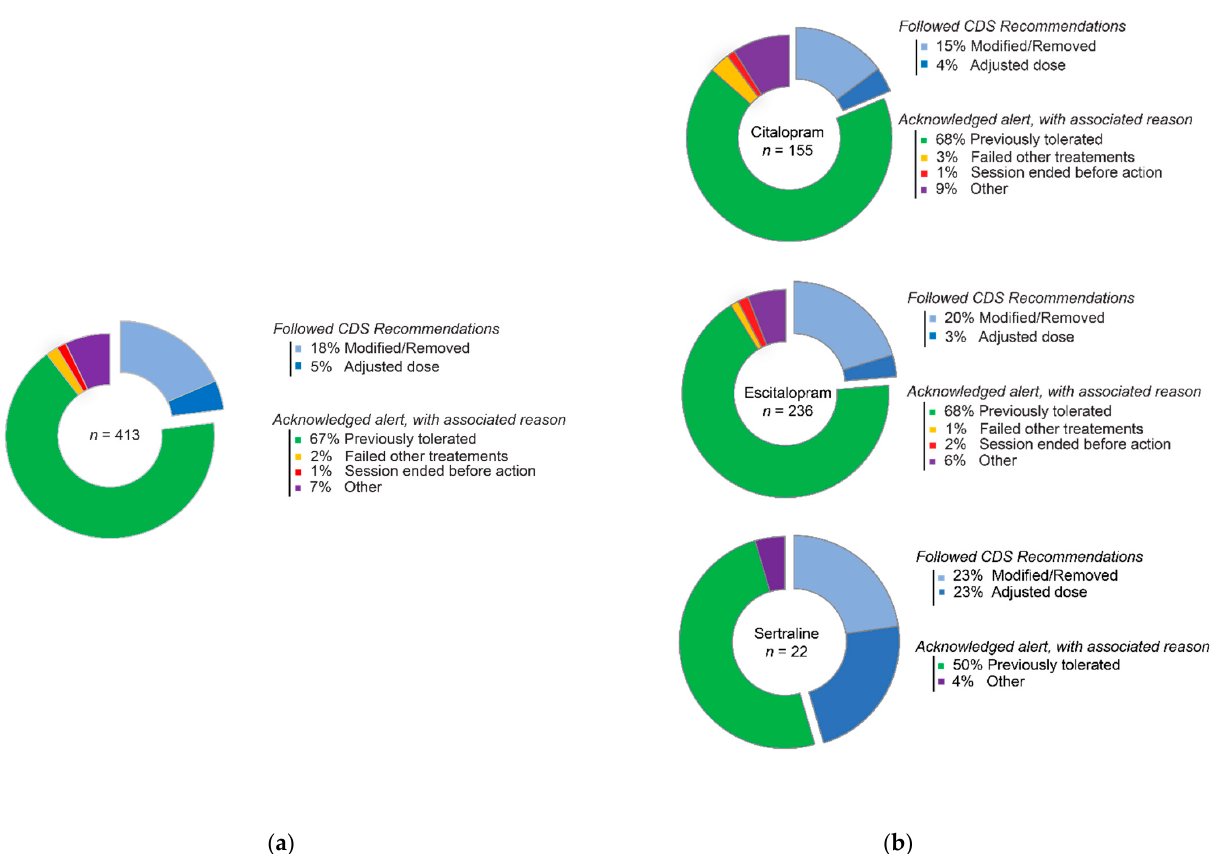
Figure 5. Acceptability and actions taken for SSRI CDS. ( a ) Combined CDS recommendations and acknowledgements for SSRIs. ( b ) Individual escitalopram, citalopram, and sertraline CDS decisions taken by health care providers.